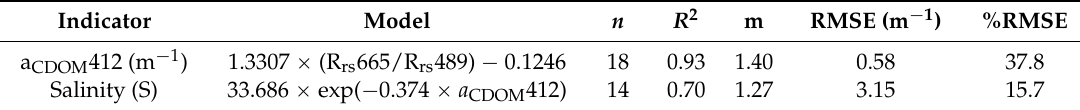
Table 6. Type II regression statistics from matchups of CDOM absorption and salinity values derived from HICO images and field data from PB and CB. Shown are the units of measurement; the number of samples used ( n ) to validate the algorithm; goodness of fit ( R 2 ) of the relationship between measured and predicted values; the slope ( m ) of the line of measured and predicted values; and the root-mean-square error of measured and predicted values.